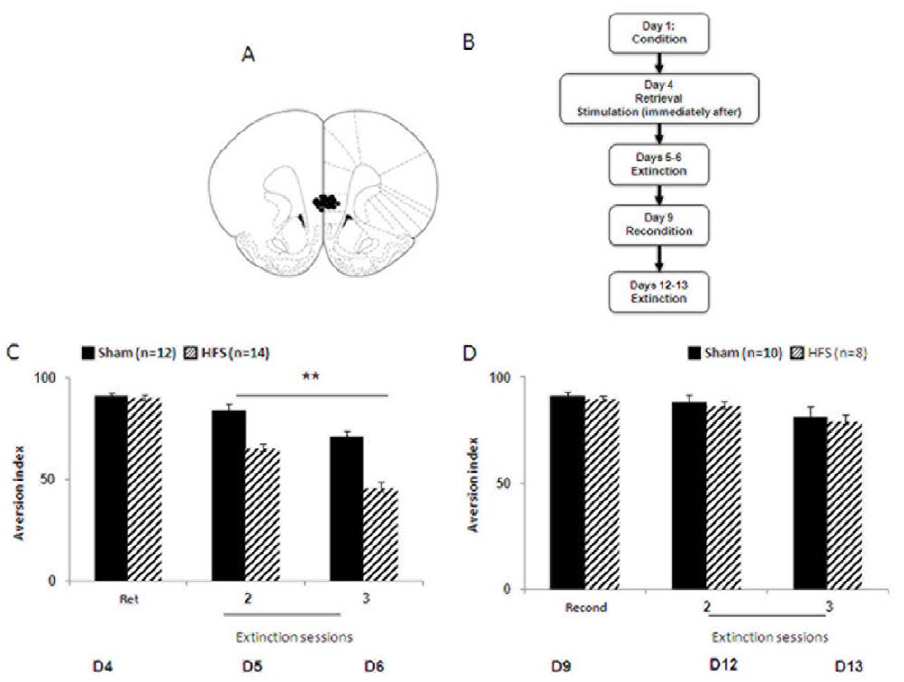
Figure 4. IL-HFS applied immediately after CTA retrieval/short extinction reduces aversion index during extinction. ( A ) Schematic diagram showing electrode placement in IL [56] for the CTA experiment. ( B ) Timeline of behavioral testing and stimulation. ( C ) Aversion index (mL water drunk/total fluid drunk 6 100) during conditioning, retrieval, and extinction in rats receiving either sham or HFS after retrieval. HFS rats showed reduced aversion during extinction relative to Shams. ** P , .01. ( D ) Aversion index during CTA to a new tastant and extinction in rats receiving either sham or HFS after retrieval. Conditioning to the new tastant and re-extinction were not affected by prior IL stimulation. Data are Means 6 SEM.